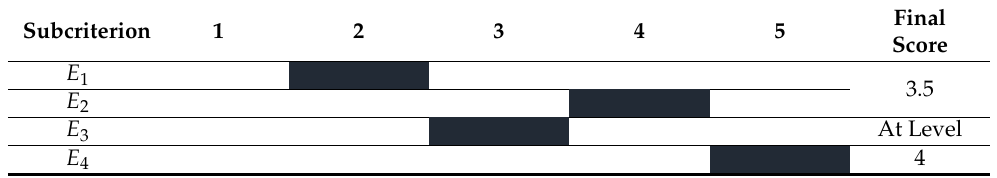
Table 4. Example of using the maturity model of resilient safety culture in Project A (error manage- ment criteria).